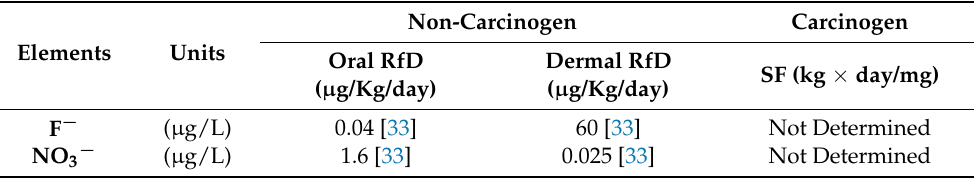
Table A3. Dermal permeability coefficient, reference dose, slope factor, and gastrointestinal